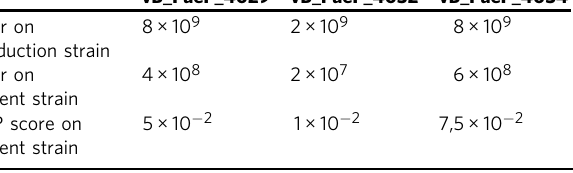
Table 1 Phagogram (Ef fi ciency of Plating [EOP]) of the non- puri fi ed phages on the patient